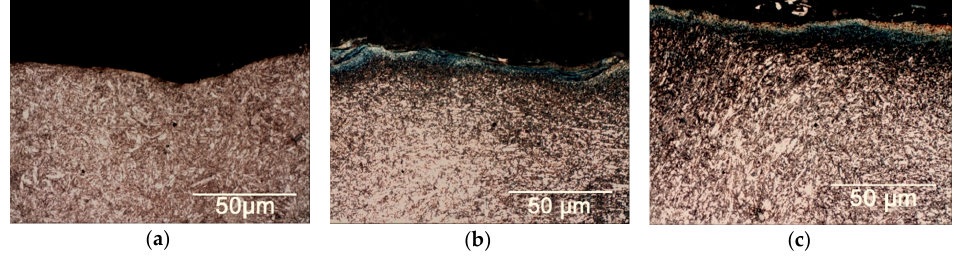
Figure 1. Surface microstructure of 39NiCrMo steel after shot peening treatment (1000×): ( a ) CSP (100% coverage), ( b ) SSP5 (5000% coverage), and ( c ) SSP10 (10,000% coverage).